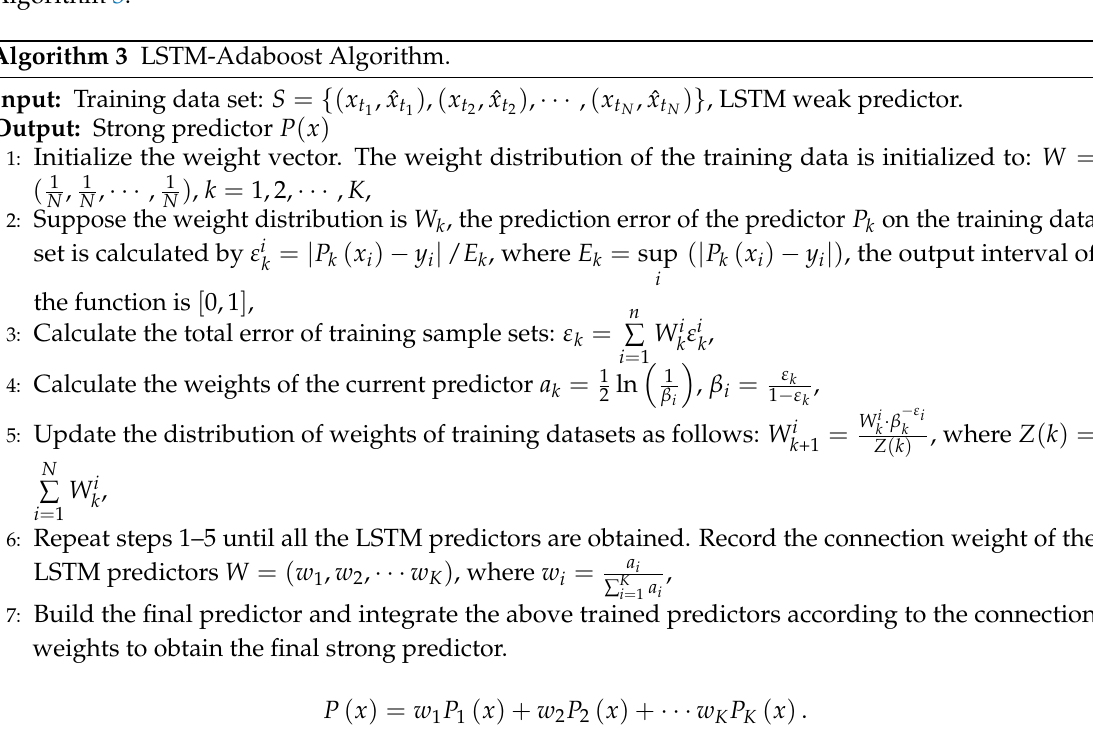
Algorithm 3 LSTM-Adaboost